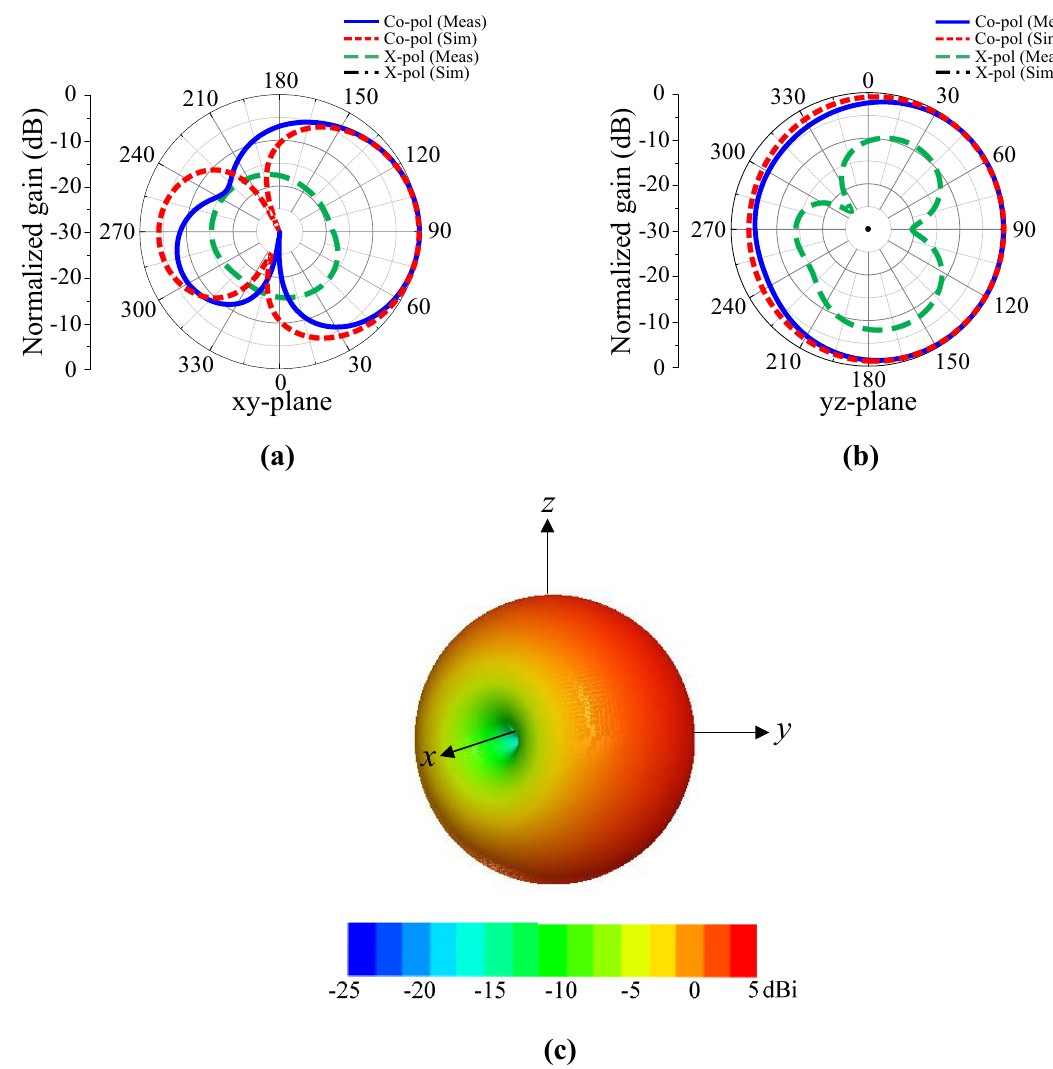
Figure 10. Normalized radiation patterns for the antenna at 2.45 GHz: ( a ) xy -plane ( b ) yz -plane, and ( c ) 3D radiation